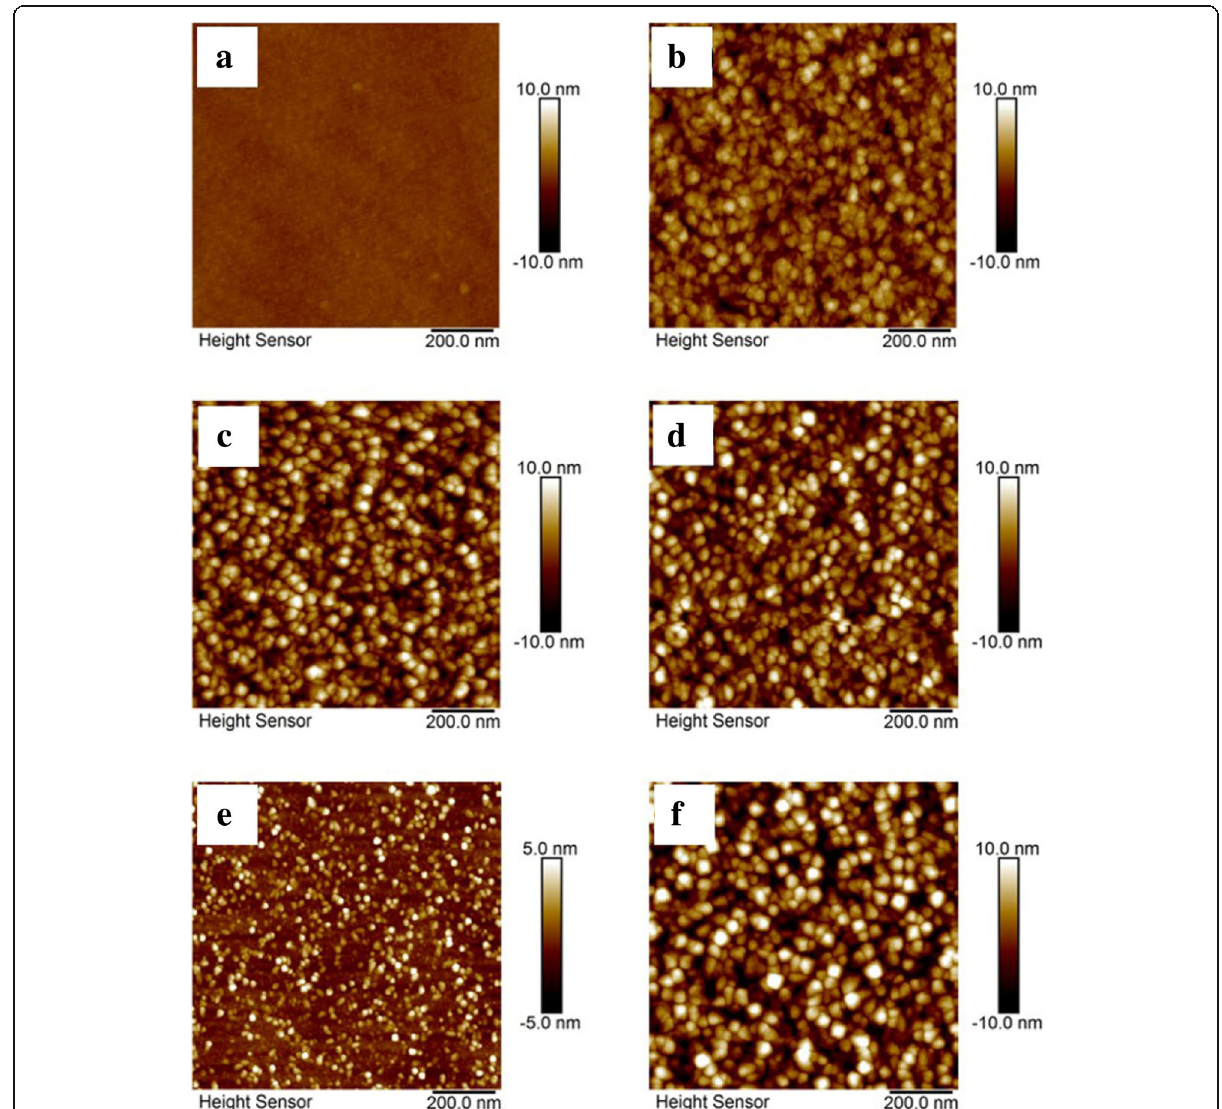
Fig. 6 AFM surface plots of ZrO 2 films deposited at 150 °C ( a ) and 350 °C ( b ), ZrO 2 films (deposited at 250 °C) annealed at 400 °C ( c ) and 1000 °C ( d ), and ZrO 2 films (deposited at 250 °C) with 200 ALD cycles ( e ) and 800 ALD cycles ( f